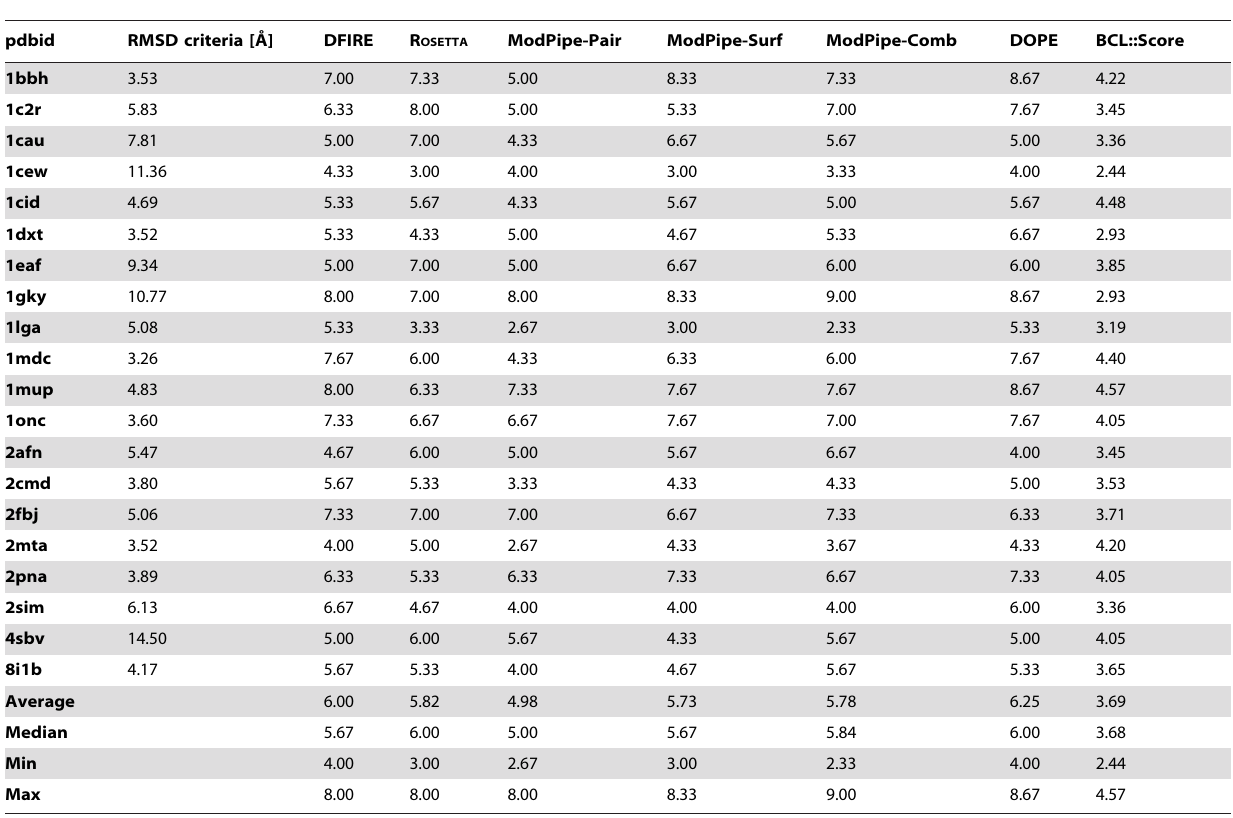
Table 5. Enrichment of native like structures within the moulder decoy set.